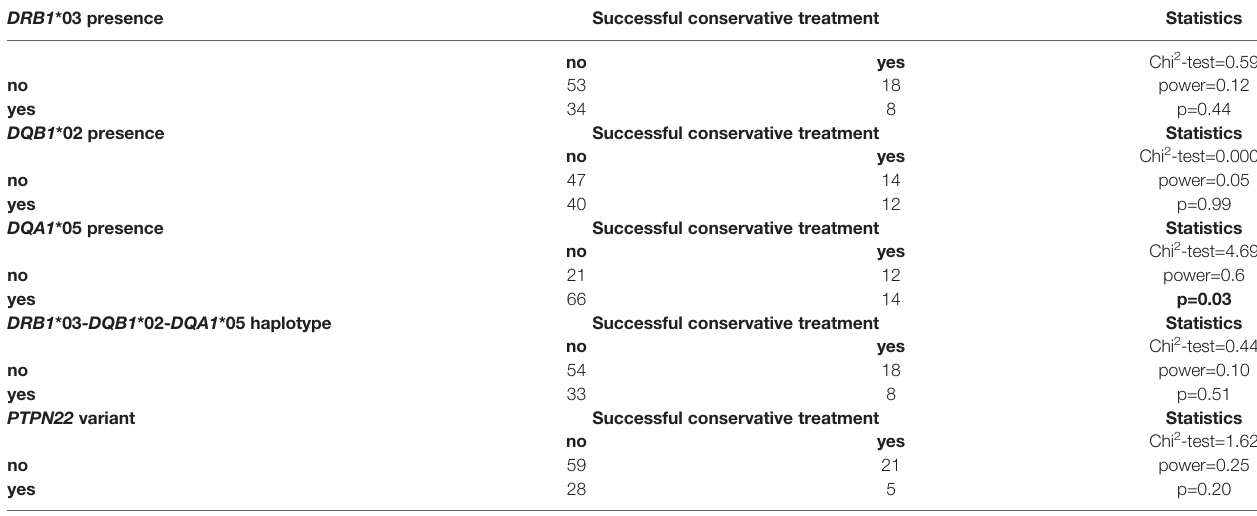
TABLE 7 | Distribution of the studied genetic variants in the group of GD patients depending on the success of the treatment, N = 113. DRB1 *03